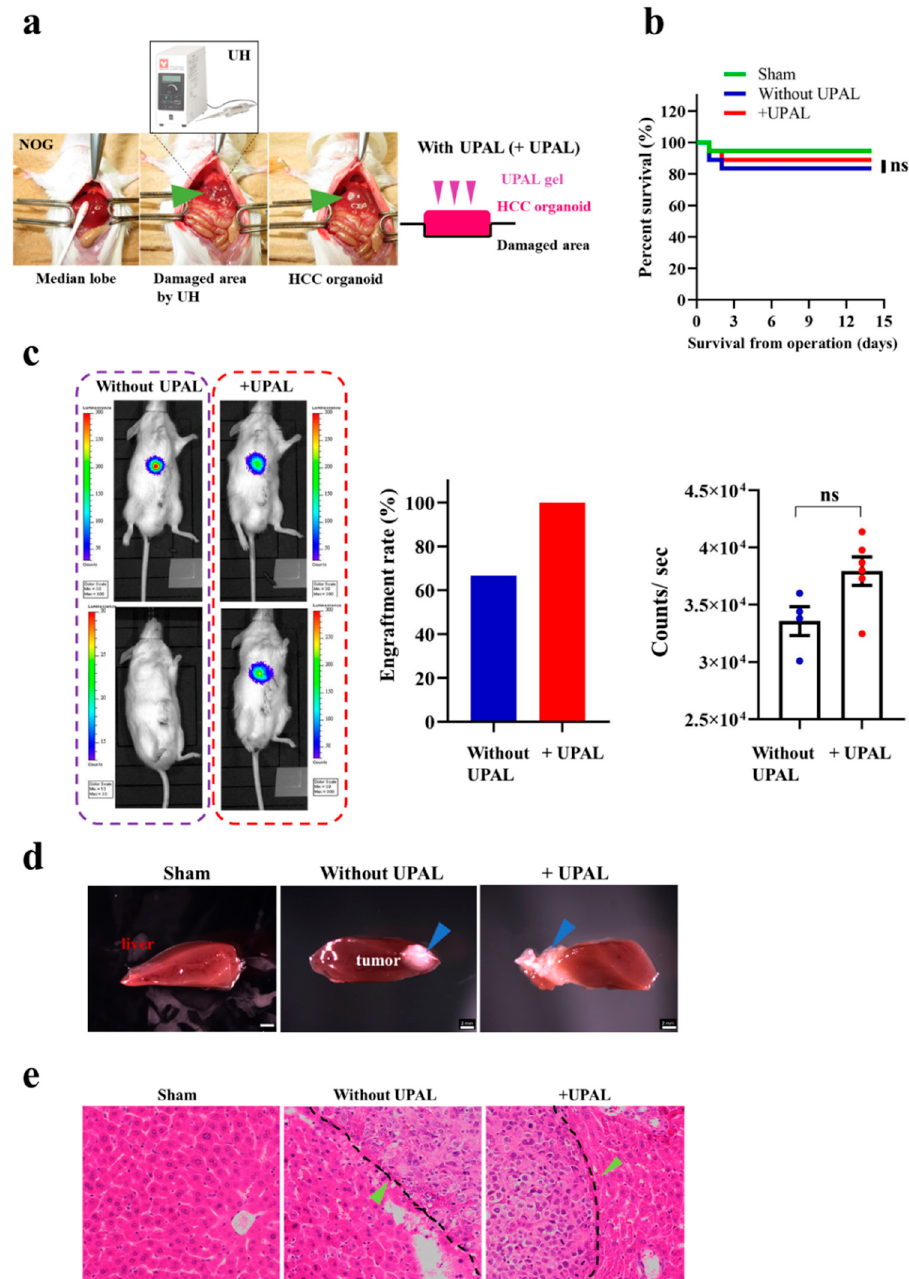
Figure 2. Implantation methods of HCC organoid onto the liver surface. ( a ) Implantation procedure of HCC organoid into mouse liver. ( b ) The survival rate of ultra-purified alginate gel-capped (+UPAL) HCC organoid implantation. Without UPAL gel-capped HCC implanted group and Sham were used as control. Log-rank test ( n = 18). ( c ) Non-invasive BLI of mouse implanted with HCC organoid; without UPAL gel-capped group (left) and UPAL-capped gel (+UPAL) group (right). Acquisitions of the fluorescence emission were performed at 1 min at a binning of 100 pixels. The relative light units/pixel is indicated in the color scale bar. Mann–Whitney U test ( n = 6/group). ( d ) Morphology analysis of mouse liver tissues implanted with HCC organoid; sham (left), HCC organoid without UPAL gel capping (center), and with UPAL gel capping (right). Blue arrows indicate tumor tissue. The scale bar represents 2 mm. ( e ) Hematoxylin and eosin (HE) staining of mouse liver after 2 weeks of HCC organoid implantation. The black dotted line indicates the junction of normal liver tissue and tumor tissue. Green arrows indicate tumor cells. The scale bar represents 50 μ m. ns: not significant.